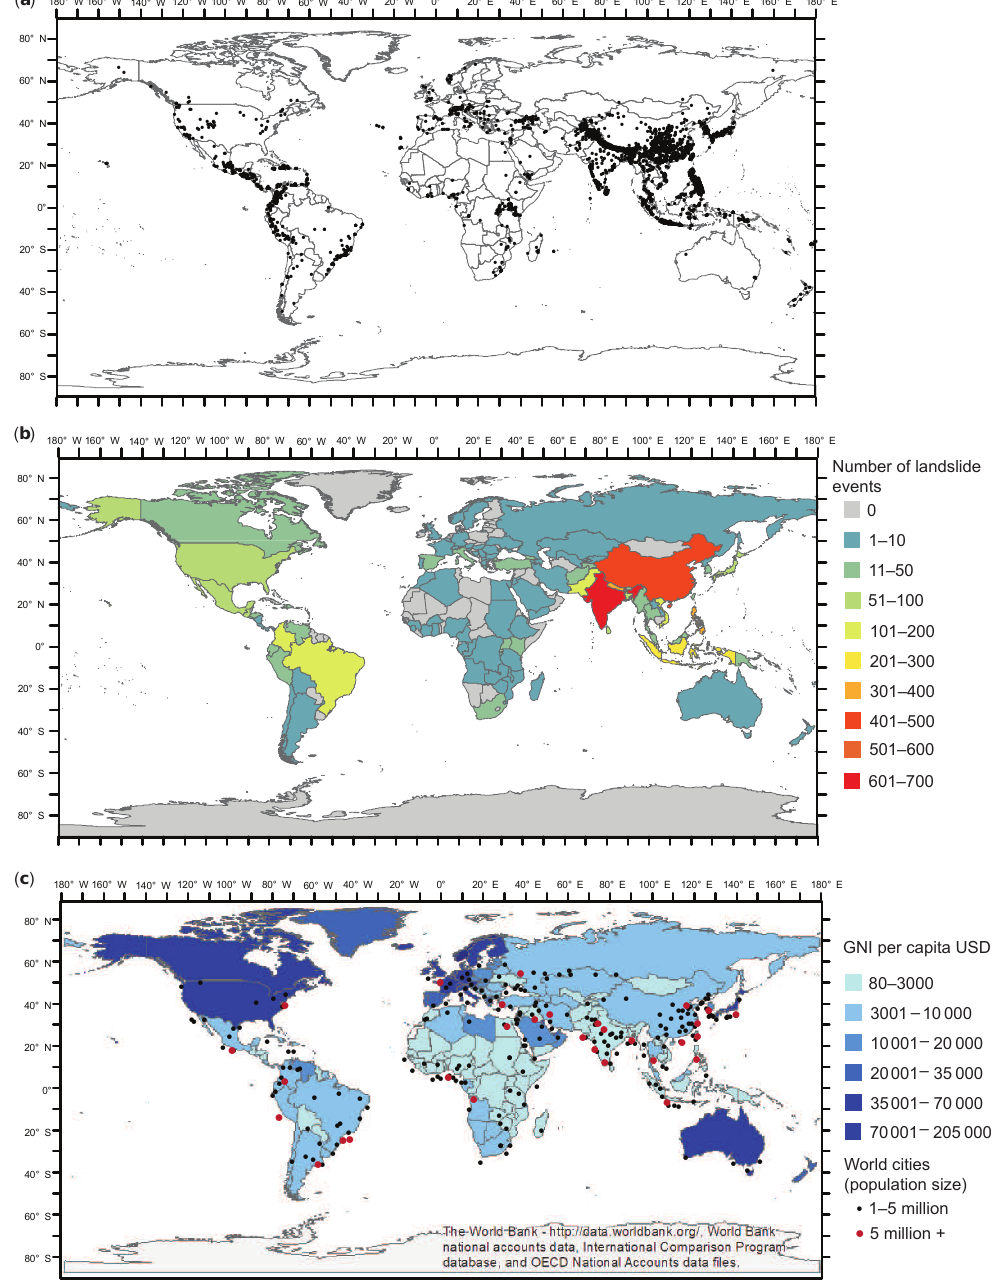
Figure 1. (a) The location of non-seismically triggered fatal landslide events from 2004 to 2016. Individual landslide events shown by a black dot. (b) Number of non-seismically triggered fatal landslide events from 2004 to 2016 by country. (c) The gross national income per capita (USD) by country (World Bank, 2018a), and the location of major urban centres globally (ESRI,